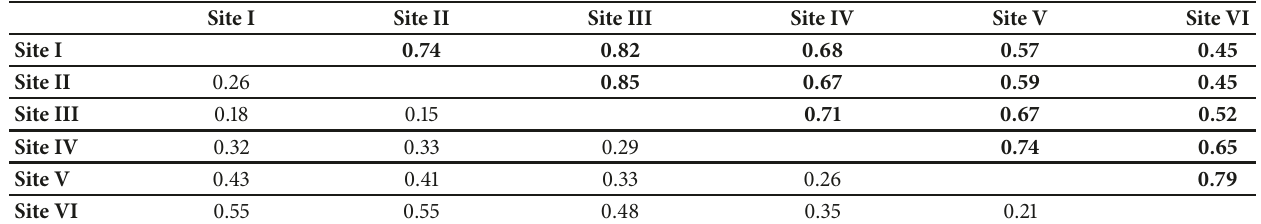
Table 15: Index of similarity and dissimilarity among different sites for Janajagaran